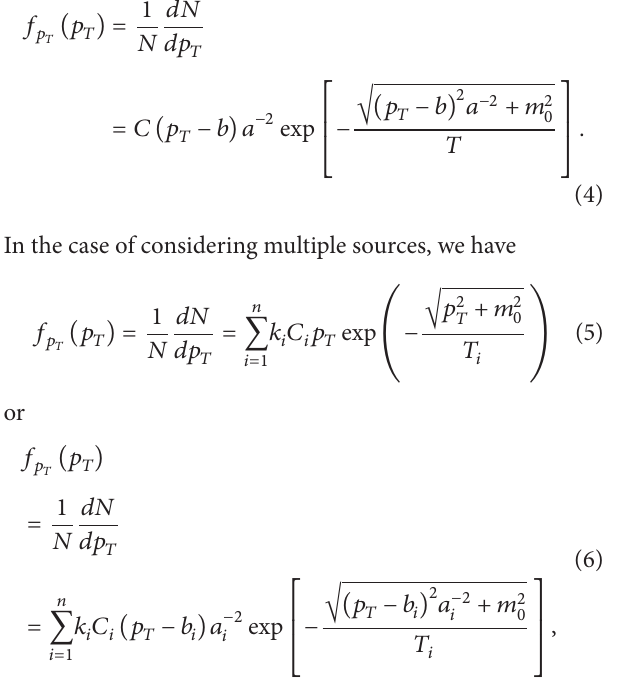
Table 3: Parameter values corresponding to the curves in Figure 3(a)/Figure 3(b). The collisions are d + Au at 200GeV.